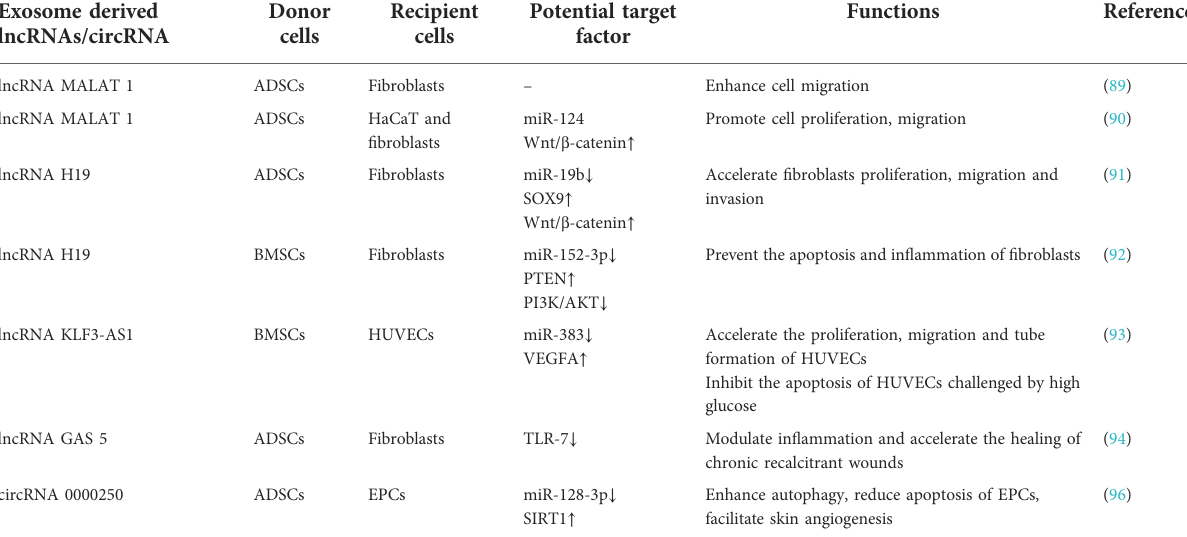
TABLE 2 Stem cell-exosome derived lncRNA/cirRNA-mediated regulation of wound healing. Exosome derived